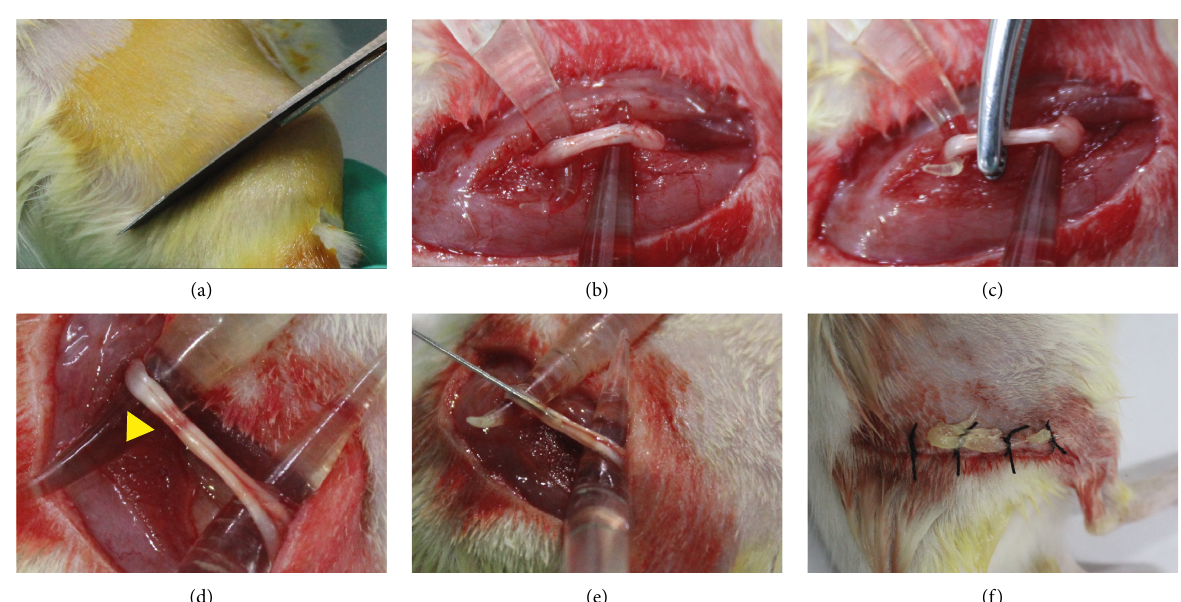
Figure 2: ADSCs therapy process. (a)–(d) The sciatic nerve was crushed with tweezers. (e) The ADSCs were injected. (f) Postoperative suture. The lesion appears transparent (yellow